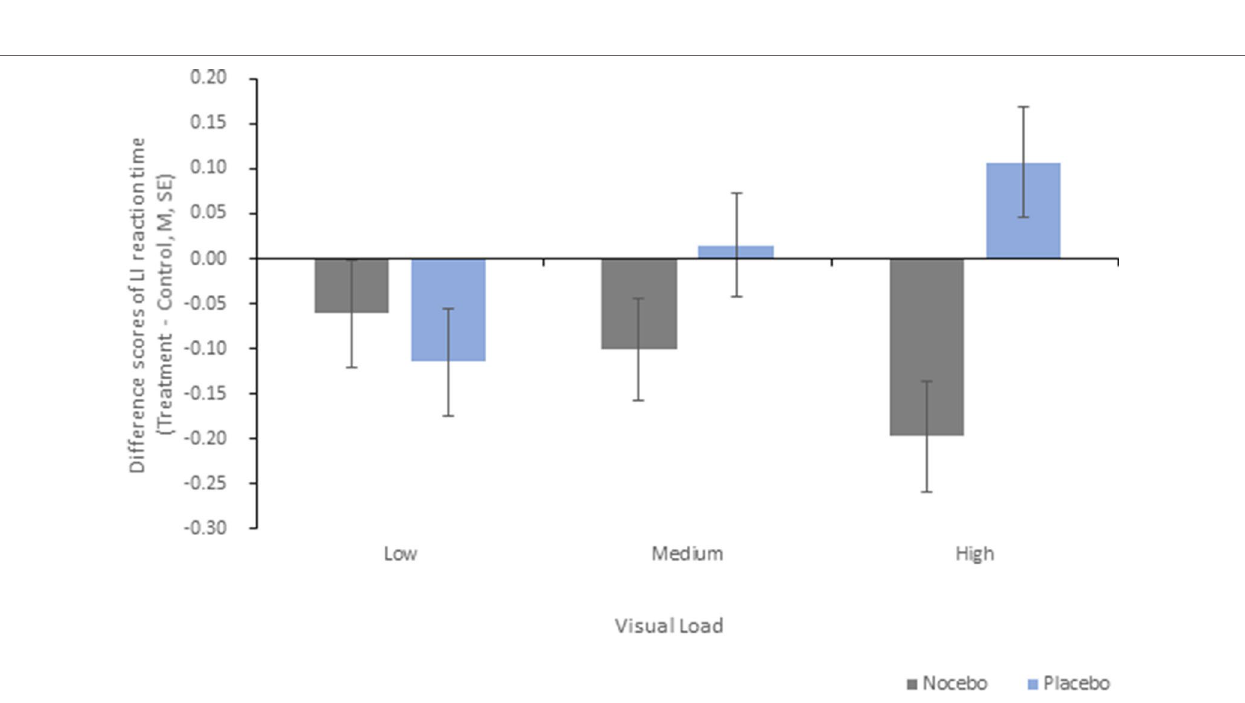
FIGURE 4 | Mean difference scores and standard errors for the lateralization index reaction time for the interaction group × visual load. Negative values indicate faster reactions for left-sided targets in the treatment condition compared with the control condition.